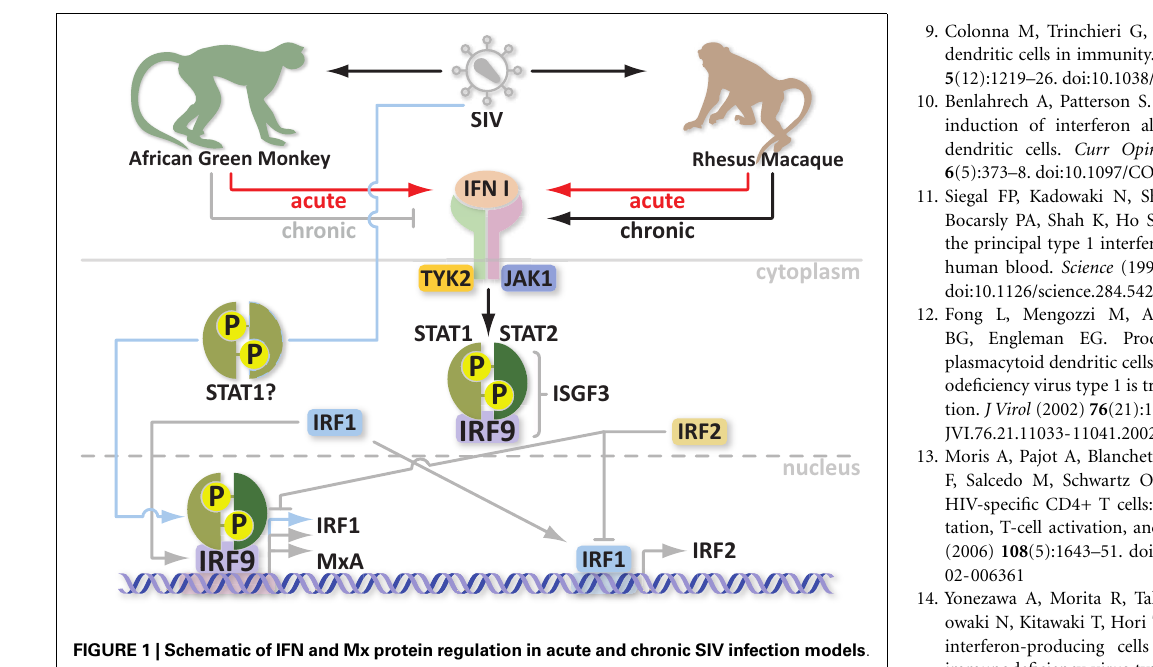
FIGURE 1 | Schematic of IFN and Mx protein regulation in acute and chronic SIV infection models